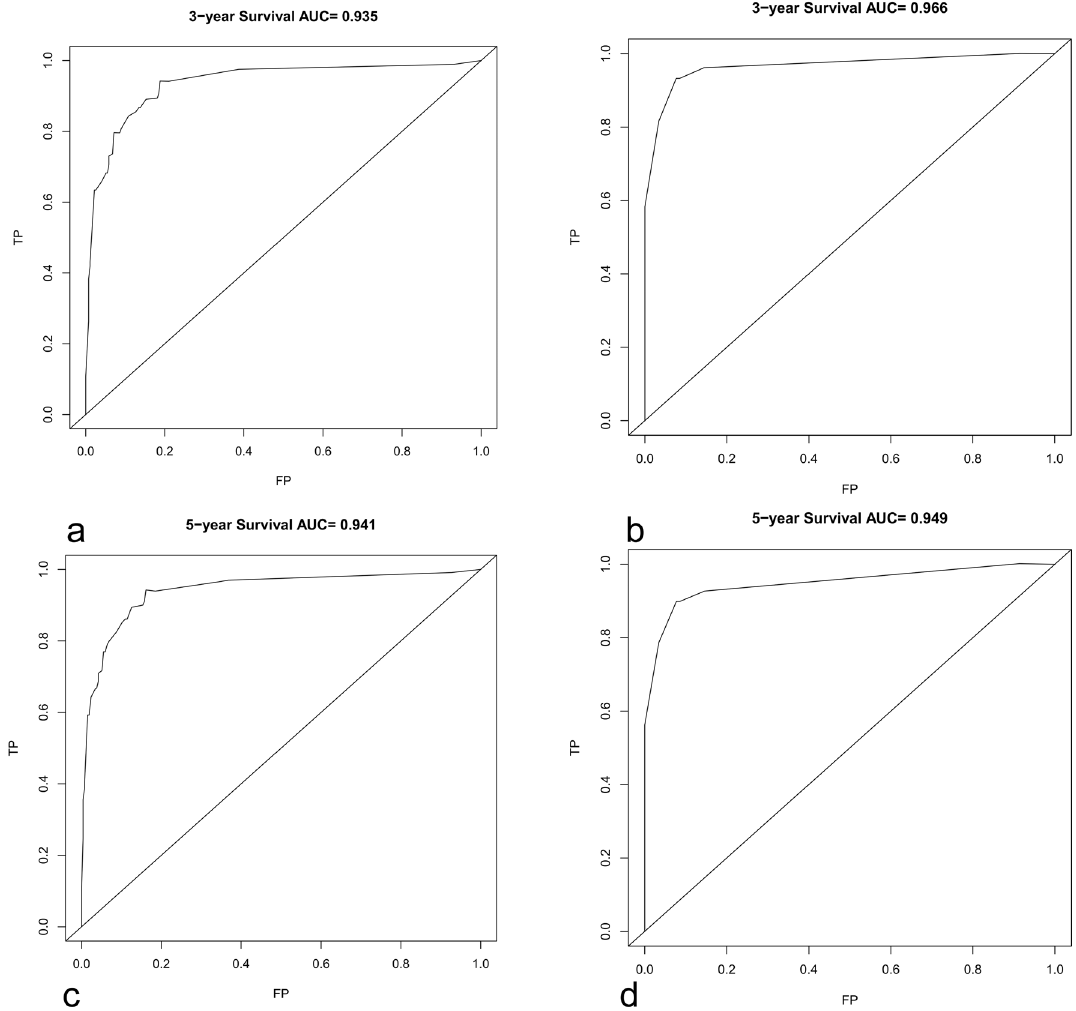
Figure 4. Time-dependent ROC curve and areas under ROC curve. Areas under ROC curve of 3-year overall survival rates in training group ( a ) and validation group ( b ). Areas under ROC curve of 5-year overall survival rates in training group ( c ) and validation group ( d